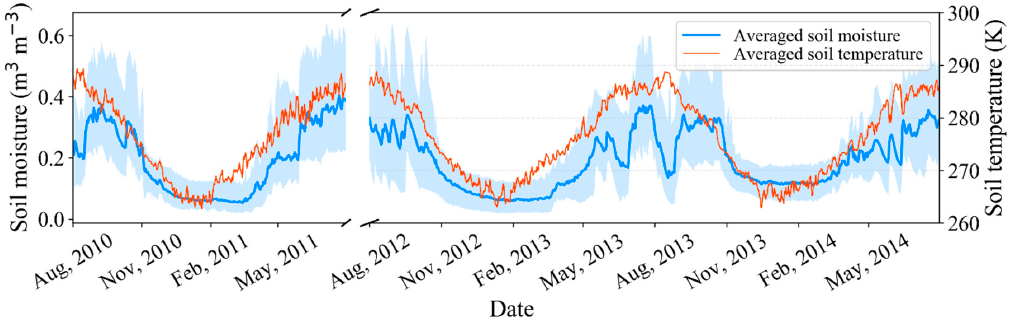
Figure 5. The seasonal variations of mean daily soil moisture measured at 5 cm in 12 stations over the study area.